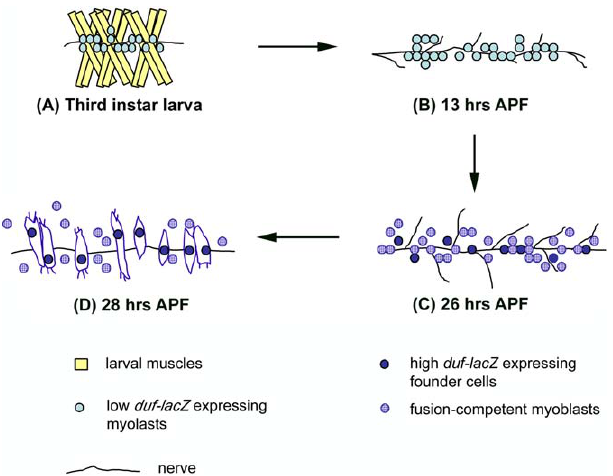
Figure 1. Schematic Representation of the Appearance of Founder Cells in the Abdomen (A) Late third instar larva. Precursor myoblasts for the adult abdominal muscles are associated with the segmental and inter-segmental nerves. These myoblasts express duf-lacZ in low levels. (B) 13 h APF. The adult myoblasts, while continuing to express low levels of duf-lacZ, proliferate and migrate out along the nerve. (C) 26 h APF. By this stage, low duf-lacZ expression in all myoblasts is replaced by higher levels of duf-lacZ in selected cells, the founder cells. The remaining cells, termed the fusion-competent cells, eventually fuse with the founder cells to form the adult myotubes. (D) 28 h APF. The nascent myotubes, founded by the founder cells, can be visualised by staining with the antibody 22C10. DOI: 10.1371/journal.pbio.0030337.g001 PLoS Biology |